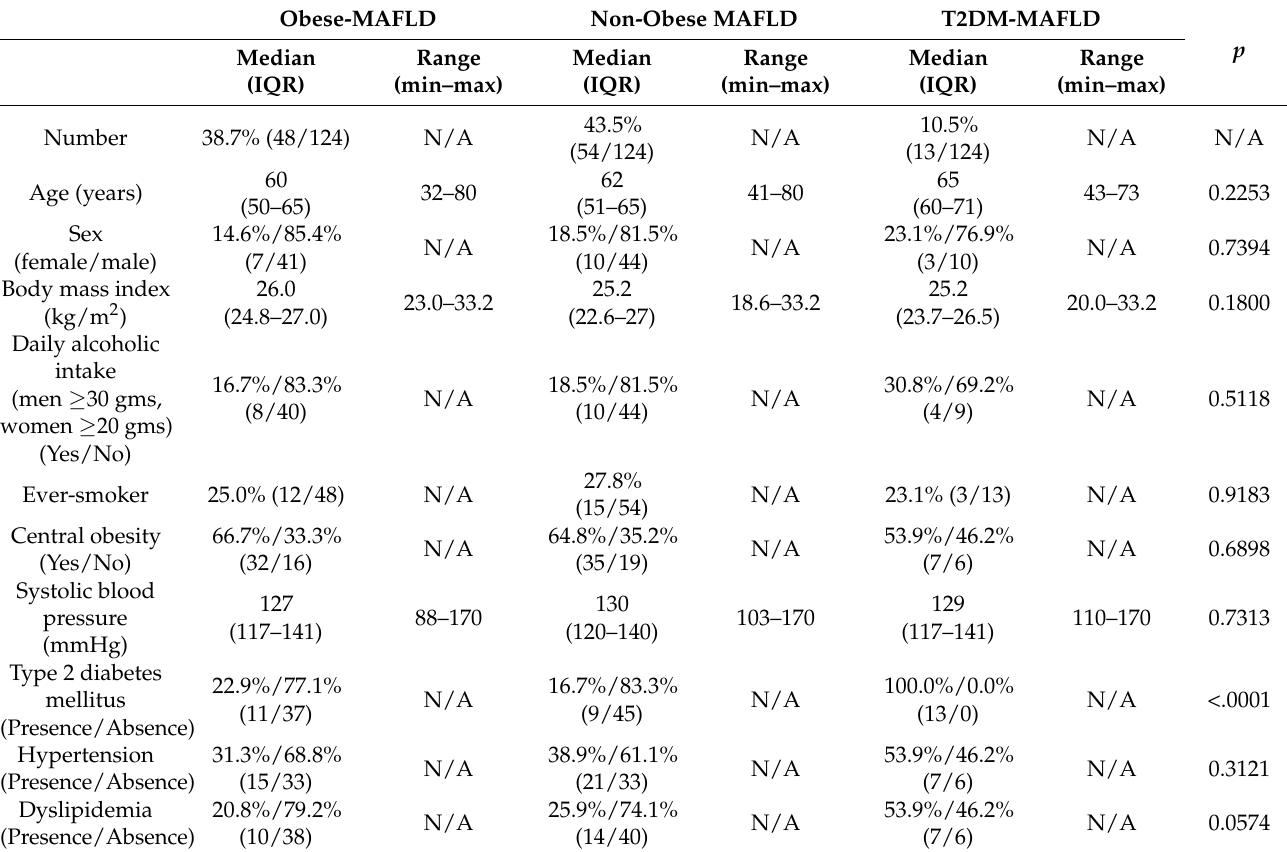
Table 2. Patients’ characteristics in subtypes of